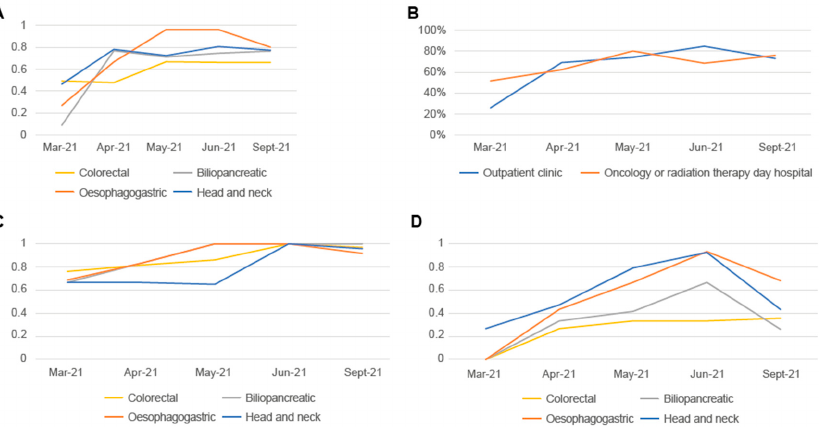
Figure 3. Nutritional assessments. ( A ) Percentage of clinical histories with nutritional assessment results among non-hospitalised patients undergoing nutritional screening by tumour type. ( B ) Per- centage of clinical histories with nutritional screening results among non-hospitalised patients in outpatient clinics or oncology/radiation therapy day hospitals. ( C ) Percentage of clinical histories with nutritional assessment results among hospitalised patients undergoing nutritional screening by tumour type. ( D ) Average percentage of tumour board sessions in which a member of the NST participated.